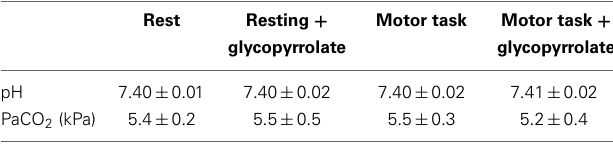
Table 3 | Arterial pH and carbon dioxide tension (PaCO 2 ). Rest Resting + Motor task Motor task